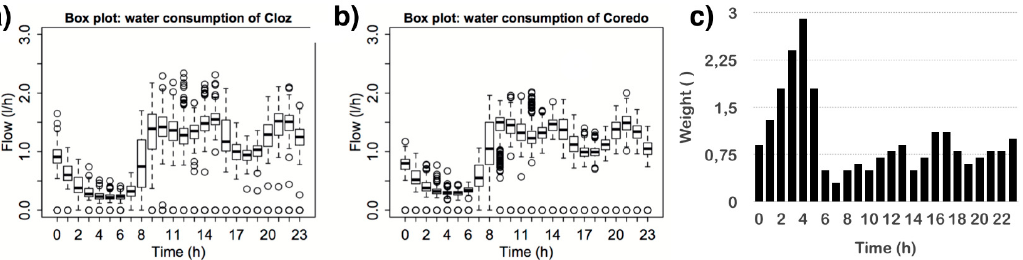
Figure 2. Box plots of hourly water consumptions (l/h) of the two Italian municipalities: Cloz ( a ) and Coredo ( b ). Weights (adimensional) are used for the definition of the target function ( c ).